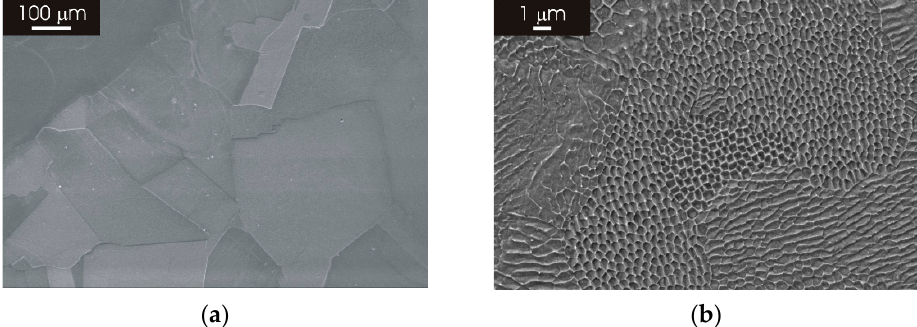
Figure 2. SEM micrographs of 316L stainless steel in the wrought condition. ( a ) Wrought condition; ( b ) after 3D printing by L-PBF in the XY direction.